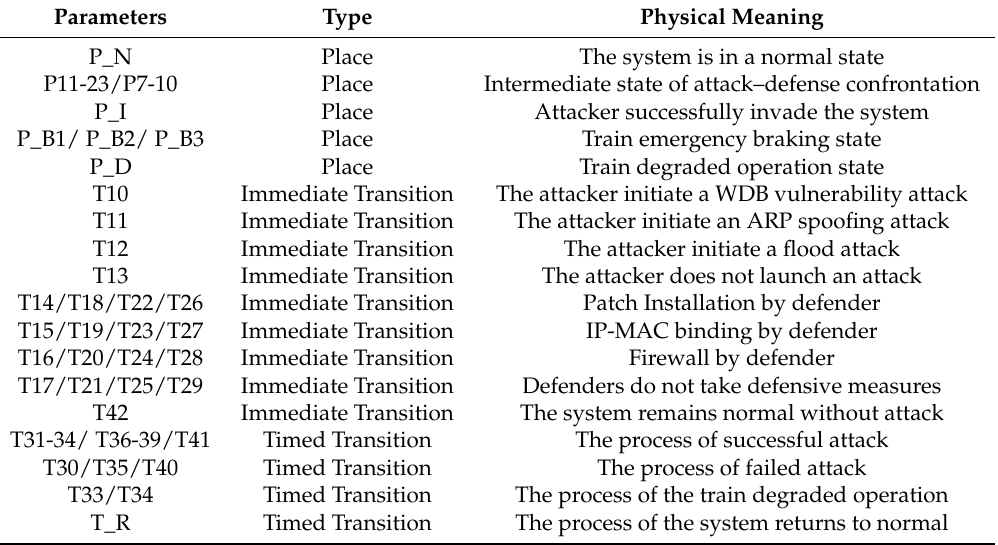
Table 4. Model parameters in the disruption